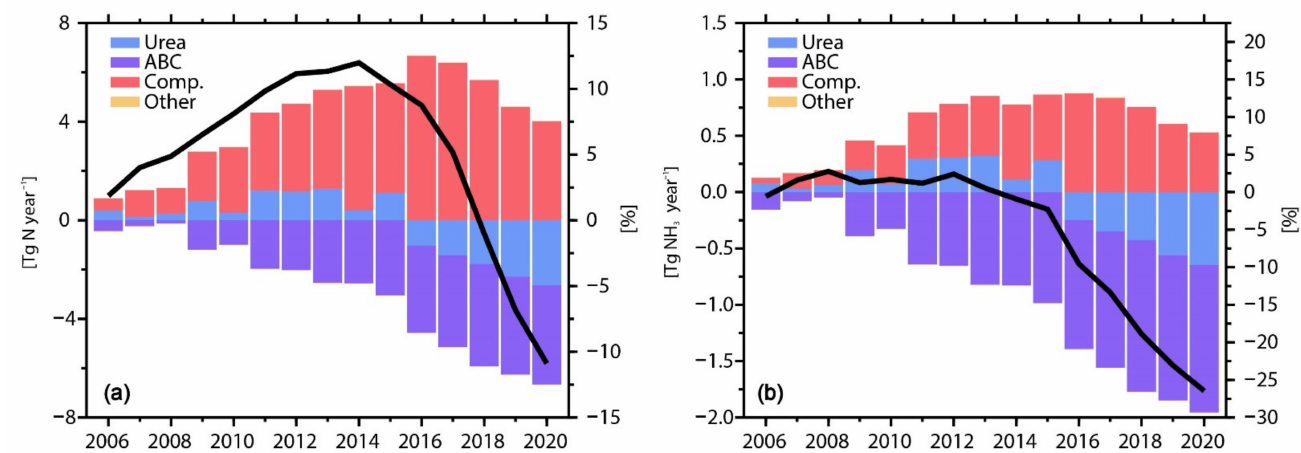
Figure 2. Interannual variation in ( a ) synthetic nitrogen fertilizer application and ( b ) resulting NH 3 emissions in China from 2005–2020; synthetic nitrogen fertilizer is categorized as urea (blue bars), ABC (purple bars), Comp. (red bars) and other (yellow bars), each bar shows the absolute change in that year relative to 2005 (Tg N year − 1 or Tg NH 3 year − 1 , left y -axis), the black line shows the total relative change (%, right y